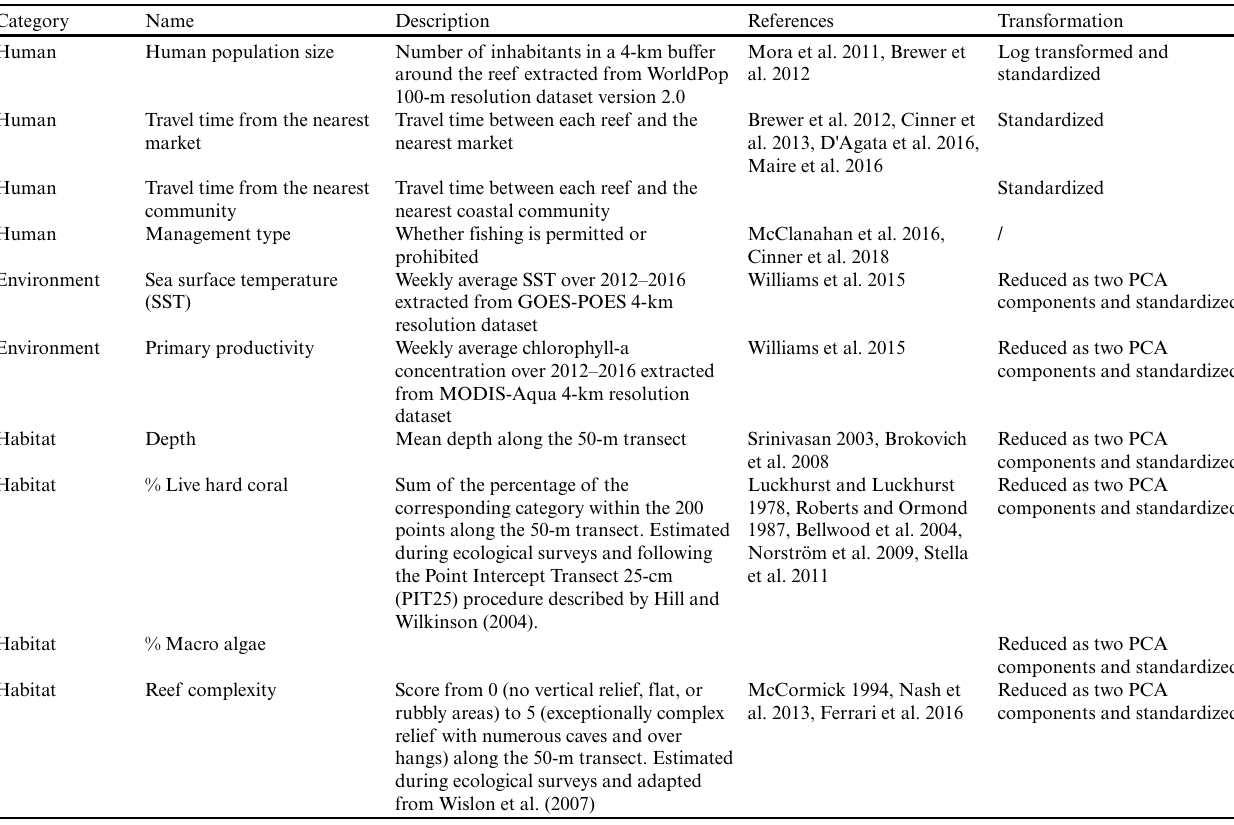
Table 1 . Name and description of human, environmental, and habitat variables considered to influence total reef fish biomass. References and statistical transformation are also described for each